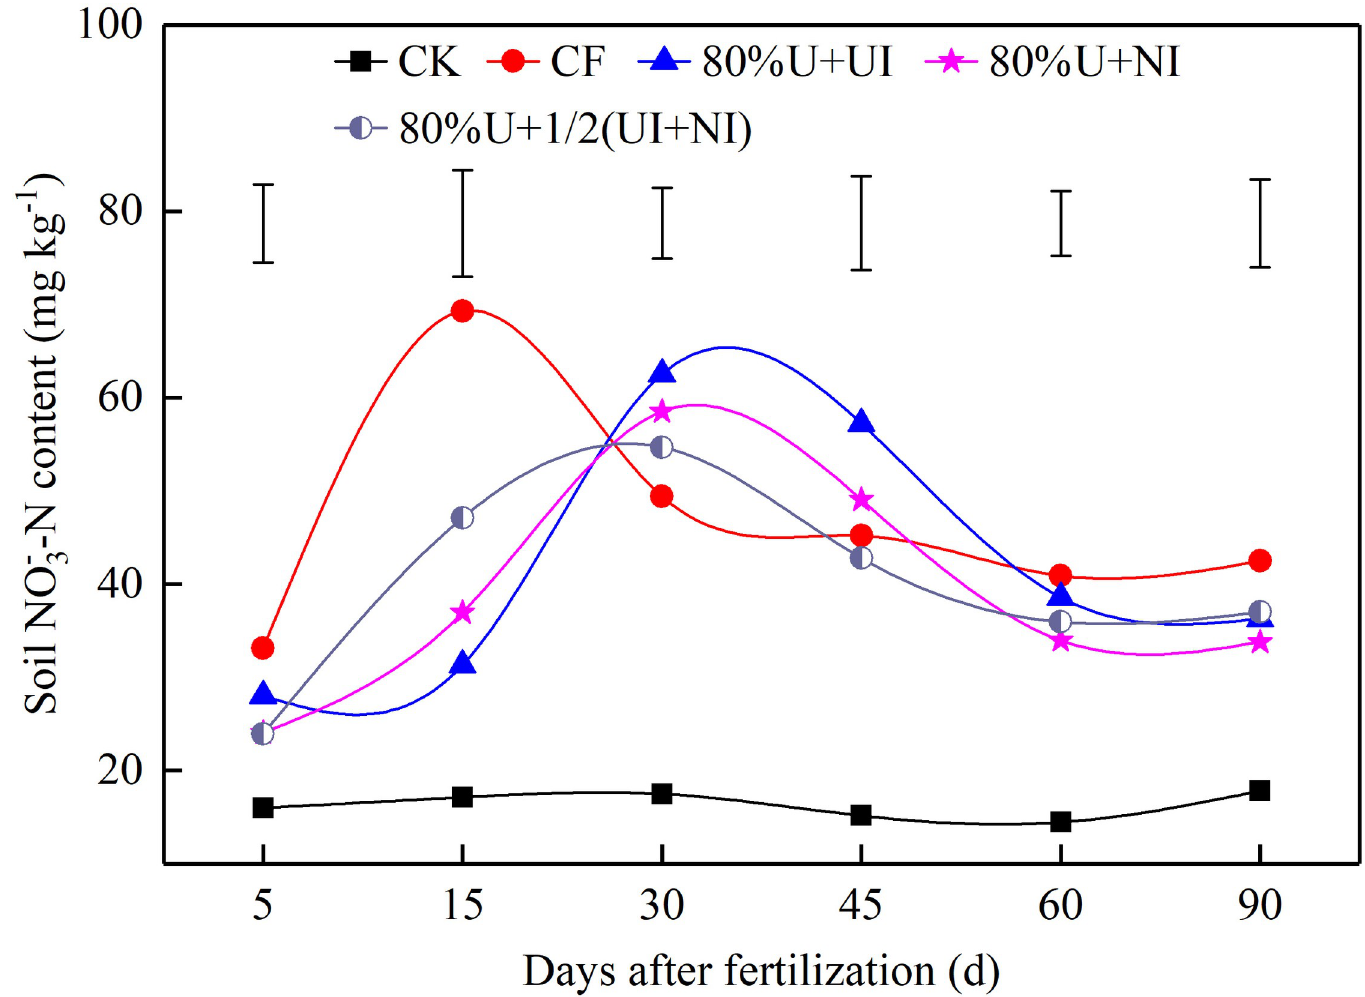
Fig 1. Mean NO (cid:0) (cid:0) N content in the 0–60 cm soil depth band from 5 to 90 days after fertilization. CK, no N fertilizer input; CF, conventional fertilization; 80%U+UI, 3 80%U+NI and 80%U+1/2(UI+NI) indicate 80% of urea input with NBPT, with DMPP and with half NBPT and half DMPP, respectively. Vertical bars represent LSD 0.05 between